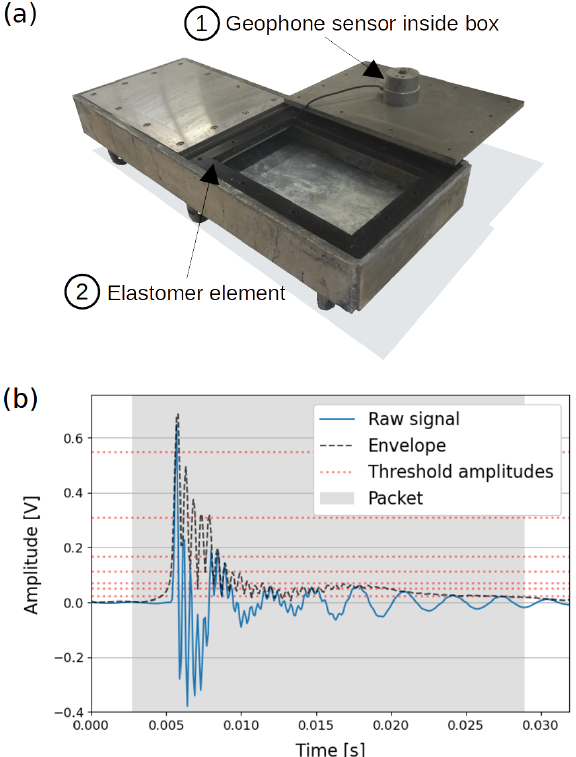
Figure 1. (a) Swiss plate geophone (SPG) system before installa- tion. Each plate is equipped with a uniaxial geophone sensor fixed in a watertight aluminum box (1) attached to the underside of the plate. The plates are acoustically isolated from each other by elas- tomer elements (2). (b) Example of a packet (grey area) detected by the SPG system. A packet begins 20 time steps (i.e., 2ms) be- fore the signal envelope crosses the lowest amplitude threshold of 0.0216V and ends 20 time steps after the last crossing of the lowest amplitude threshold (see Sect.